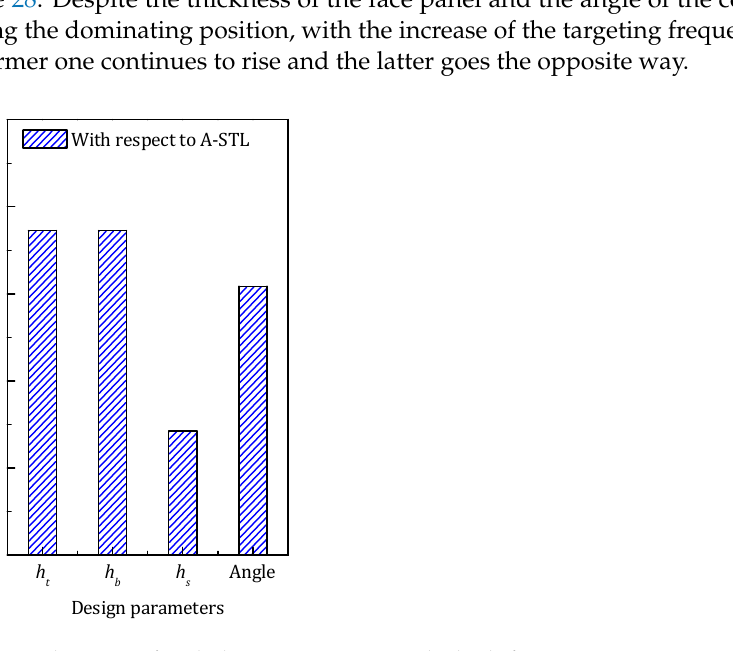
Figure 27. Optimization samples distribution of three design parameters (high-frequency range). ( a ) Optimization sam- ples distribution of h t ; ( b ) Optimization samples distribution of φ ; ( c ) Optimization samples distribution of h s .